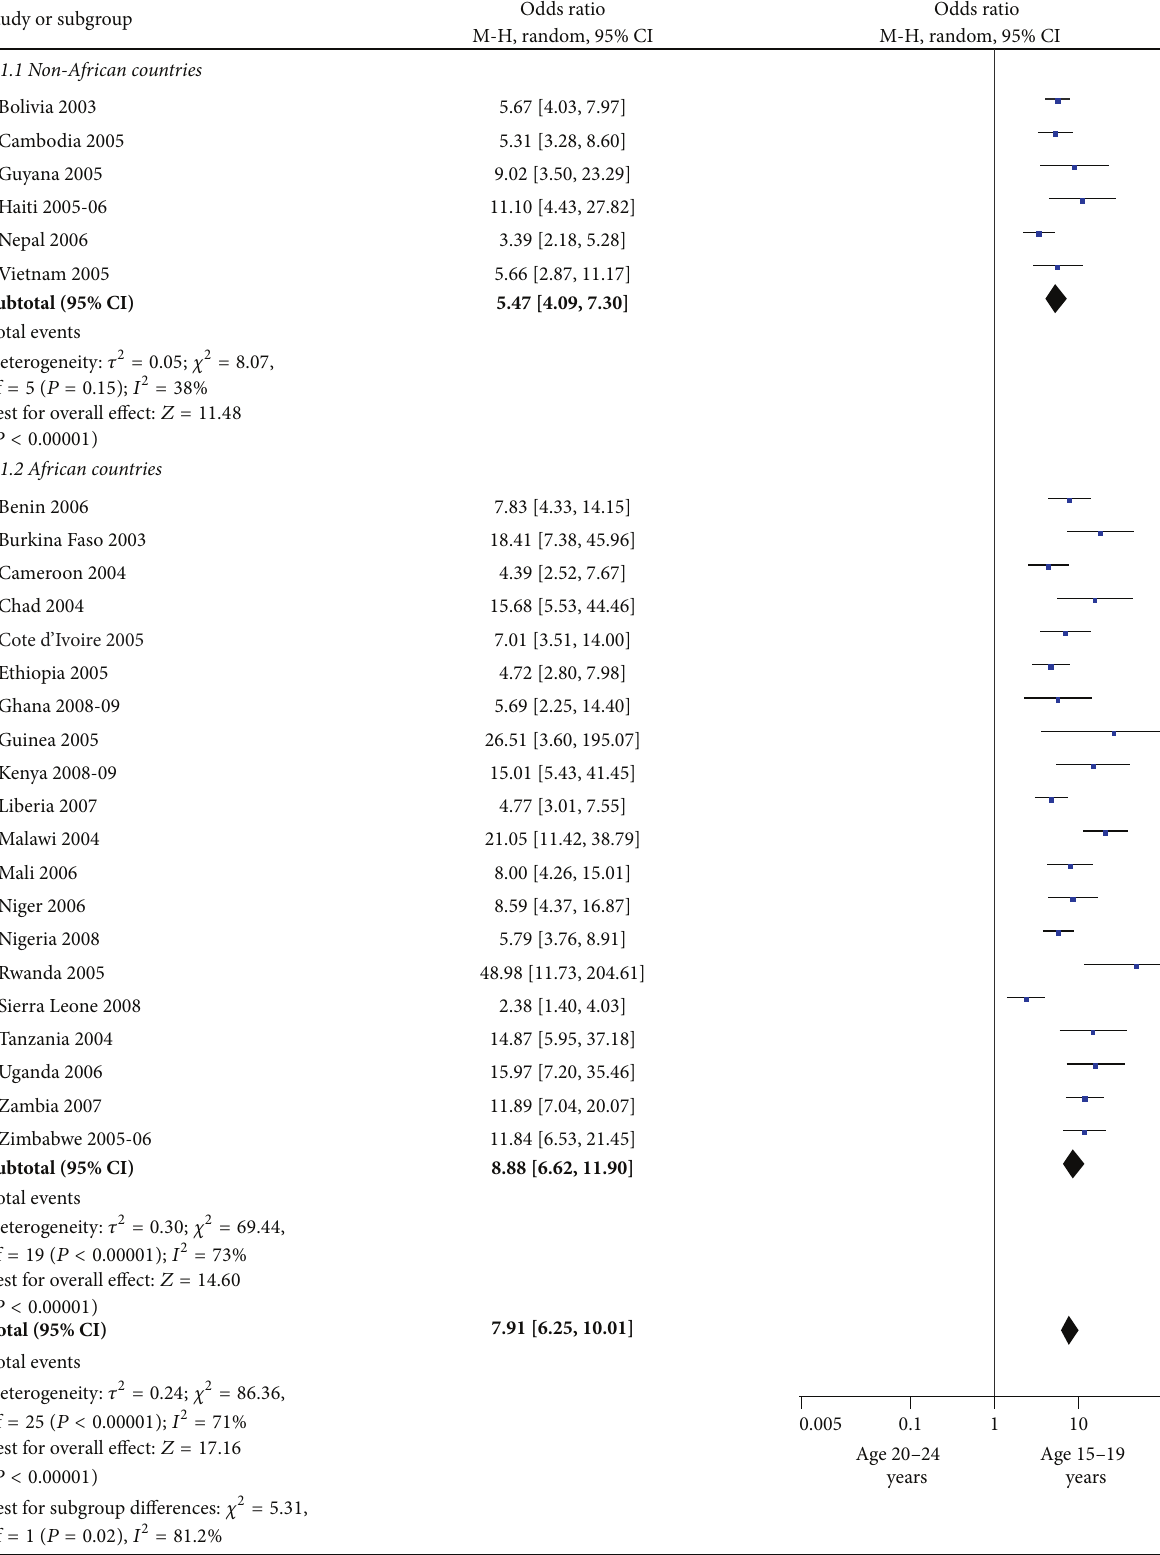
Figure 1: Among male youths aged 15–24 years, higher-risk sex practices in past 12 months by age group (2003–2009). M-H = Mantel- Haenszel statistic; CI = confidence